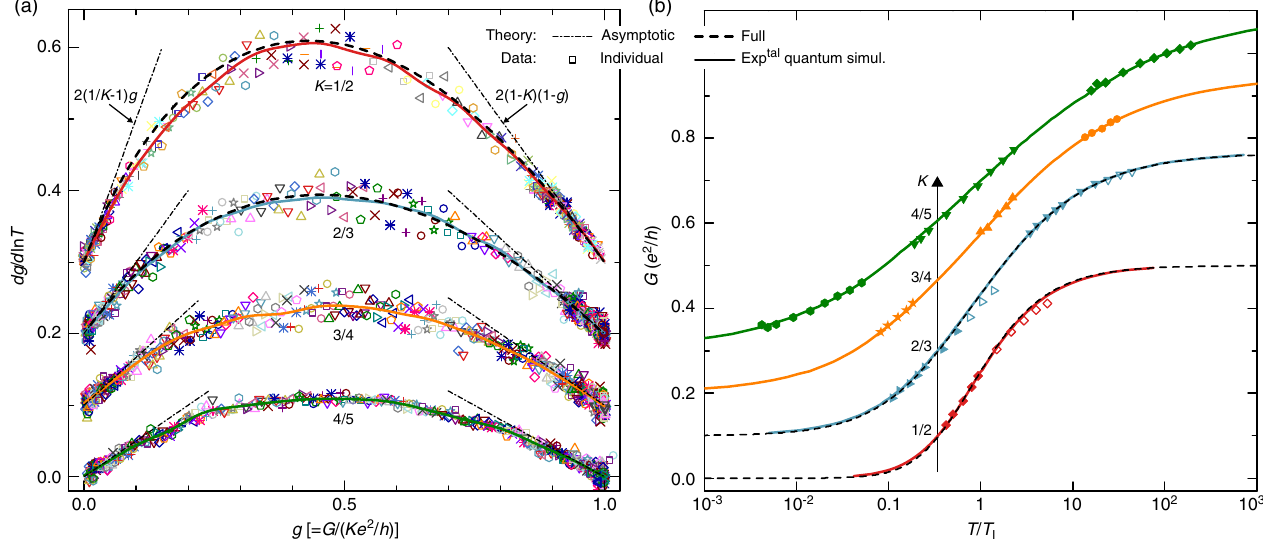
FIG. 2. Universal conductor-insulator crossover. In both panels, data points for a fixed device tuning of τ at different temperatures are shown with identical symbols. For clarity, vertical shifts of 0.1 are applied between K ∈ f 1 = 2 ; 2 = 3 ; 3 = 4 ; 4 = 5 g ( R ∈ f 1 ; 1 = 2 ; 1 = 3 ; 1 = 4 g h=e 2 , respectively). Colored continuous lines represent the experimental quantum-simulated solutions, obtained by averaging the data ensemble. Exact TLL predictions ( K ∈ f 1 = 2 ; 2 = 3 g only) are shown as black dashed lines. g Þ . Individual data points are the discrete temperature differentiation, at (a) displays the renormalization-group beta functions β K ð g Þ slopes fixed τ , of conductance measurements δ g= δ ln T , with g ≡ G= ð Ke 2 =h Þ . Black dash-dotted lines show the asymptotic β K ð T=T predicted near the g ¼ 0 and g ¼ 1 fixed points. (b) displays the universal conductance flows G . Quantum-simulated K ð I Þ g Þ shown in (a). Direct conductance measurements are also displayed curves are obtained by integrating the experimental β K ð τ ; K Þ adjusted at temperatures well below the high-energy RC cutoff. Full symbols for representative settings of τ , with T I ð RC is verified. Nonuniversal deviations can develop at higher temperatures (open indicate that the universality criteria T ≲ h= 25 k B